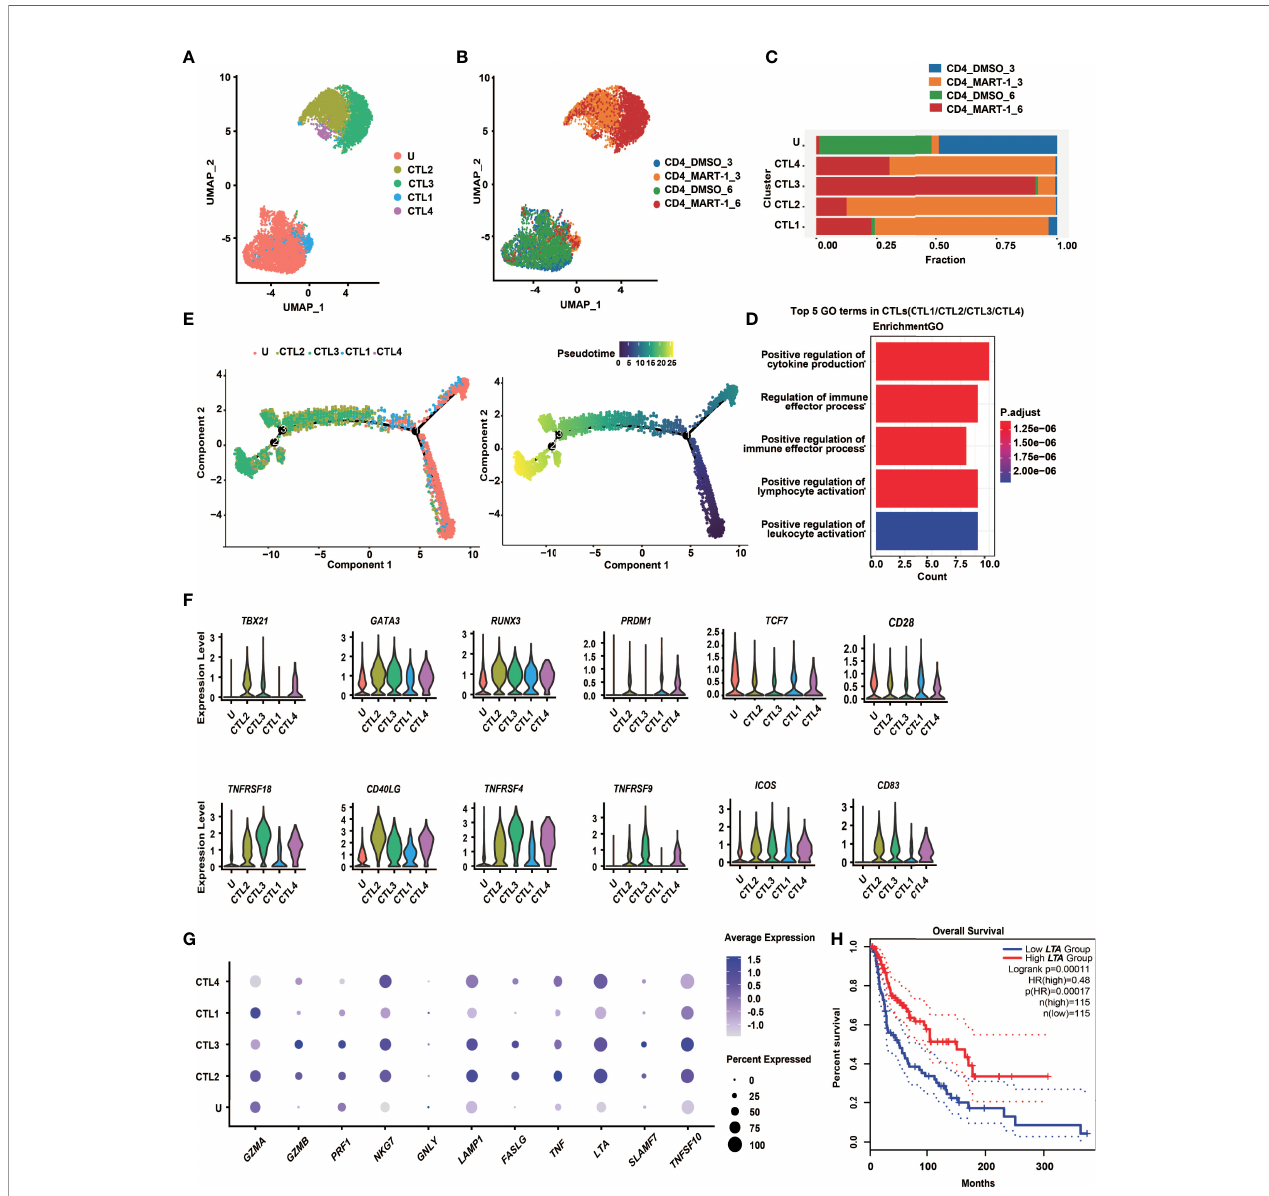
FIGURE 4 | CD4 + TCR-T clusters showed temporal transcriptome pro fi les, mixed Th1/Th2 phenotypes and unique cytotoxic signatures. (A) UMAP projection of the expression pro fi les of the 7825 CD4 + TCR-T cells. (B) UMAP manifolds colored by sample origins. (C) Stacked bar chart of sample origins in each CD4 + TCR-T cluster. (D) GO pathway analysis of CTL1/2/3/4 compared with cluster U. Top 30 DEGs were used for analysis. Top 5 GO-BP terms were displayed. The color key from red to blue indicates P values (P < 0.05) from low to high. Count: The number of genes enriched to this GO entry from the input gene for enrichment analysis. (E) Pseudotime trajectory plot of CD4 + TCR-T cells across the pseudotime trajectory. (F) Violin plots show expression of selected transcription factors and costimulatory molecules in CD4 + TCR-T clusters. (G) Dot plots show expression of representative cytotoxic genes in CD4 + TCR-T clusters. (H) Kaplan-Meier overall survival curves of TCGA SKCM patients grouped by LTA expression. P value was calculated by a log-rank test. DEG, differential expressed gene; GO, gene ontology; UMAP, uniform approximation and projection; BP, biological